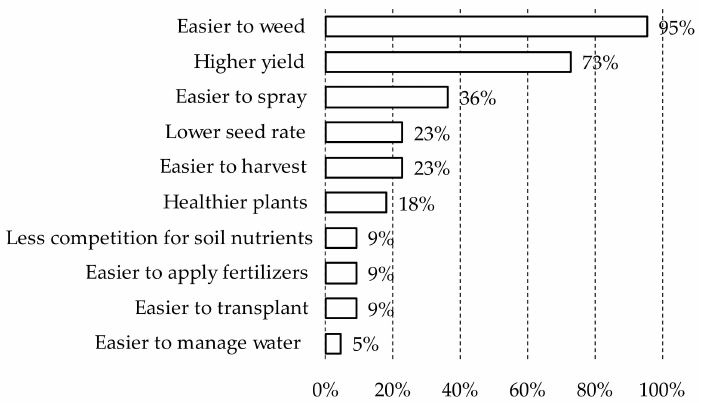
Figure 7. Farmer perceived advantages of transplanting rice in lines when compared to random transplanting.